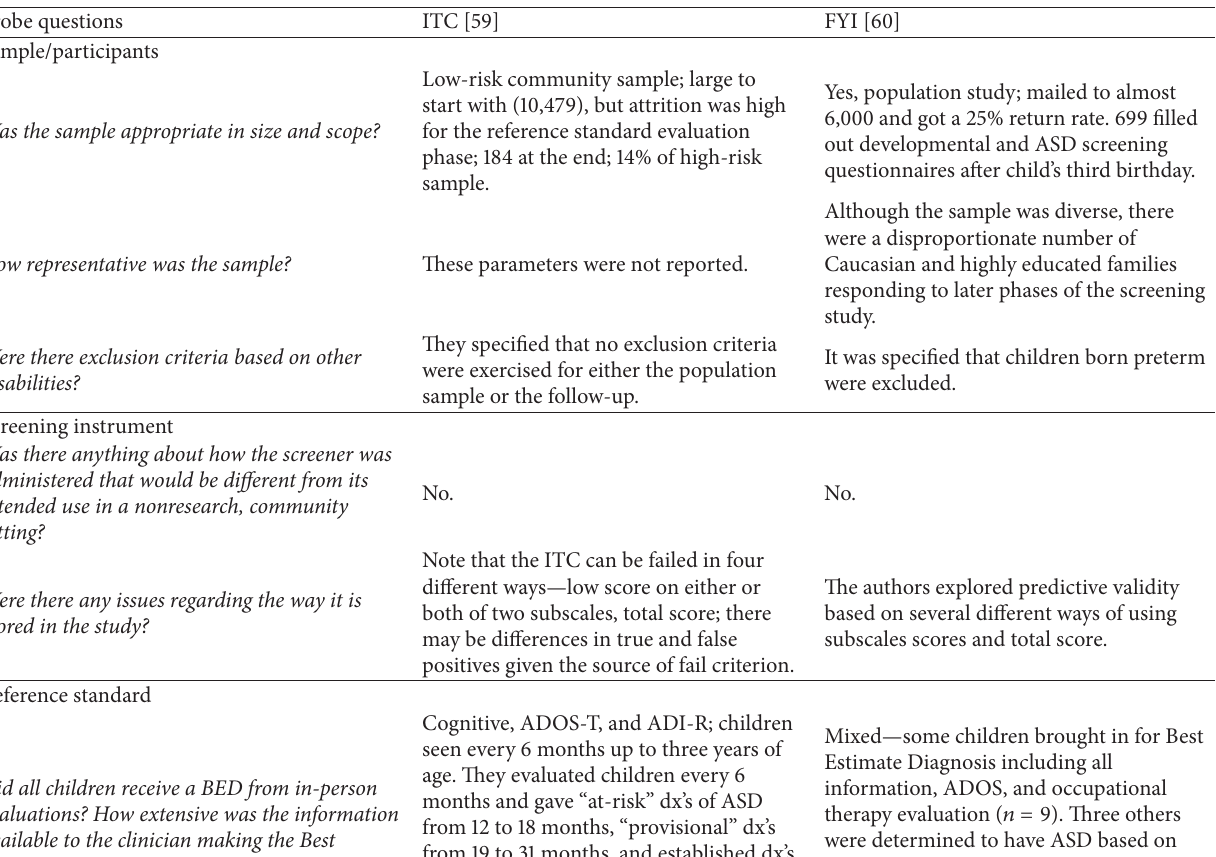
Table 3: Research summaries for the Infant-Toddler Checklist (ITC) and First-Year Inventory